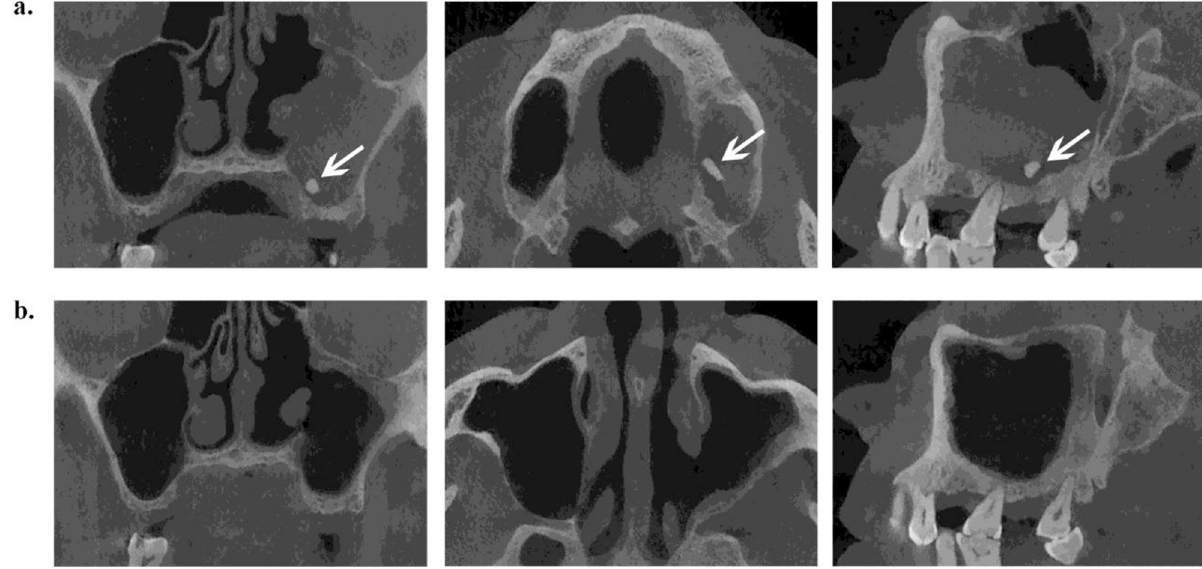
Fig 6. Radiological monitoring — CBCT: Frontal/axial/sagittal section a. The root is visible at the bottom of the left maxillary sinus. This examination reveals a partial but signi fi cant fi lling of the left maxillary sinus (arrow). b. Postoperative radiological examination performed 6 months after tooth recovery, showing good healing of the left maxillary sinus and ethmoid cells. This examination also shows a widened meatus following the meatotomy